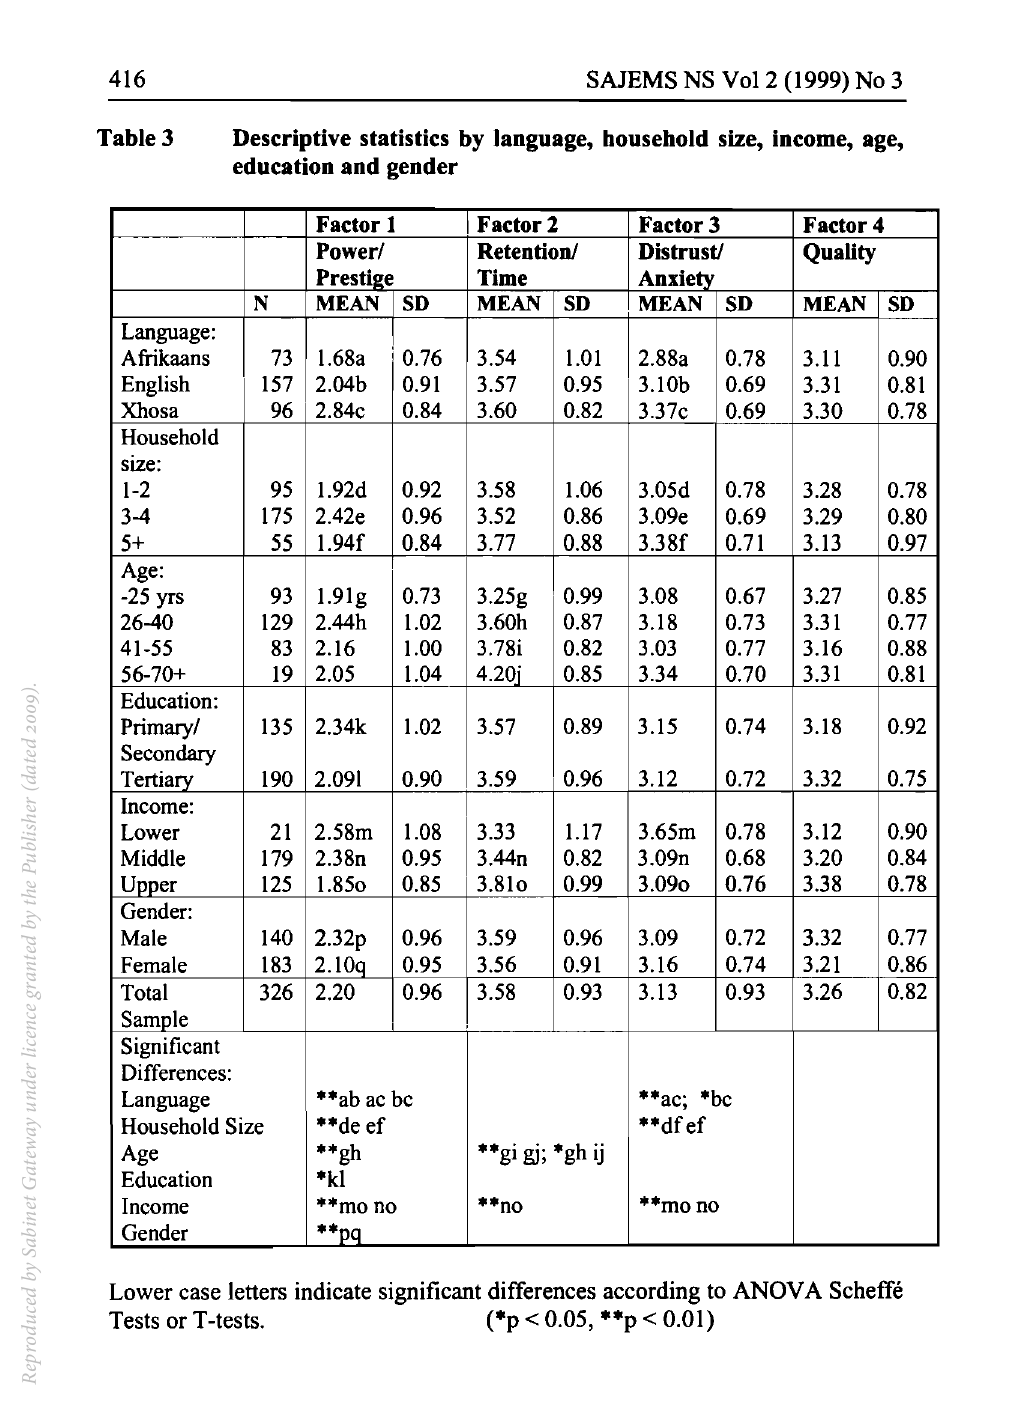
Lower case letters indicate significant differences according to ANOV A Scheffe Tests or